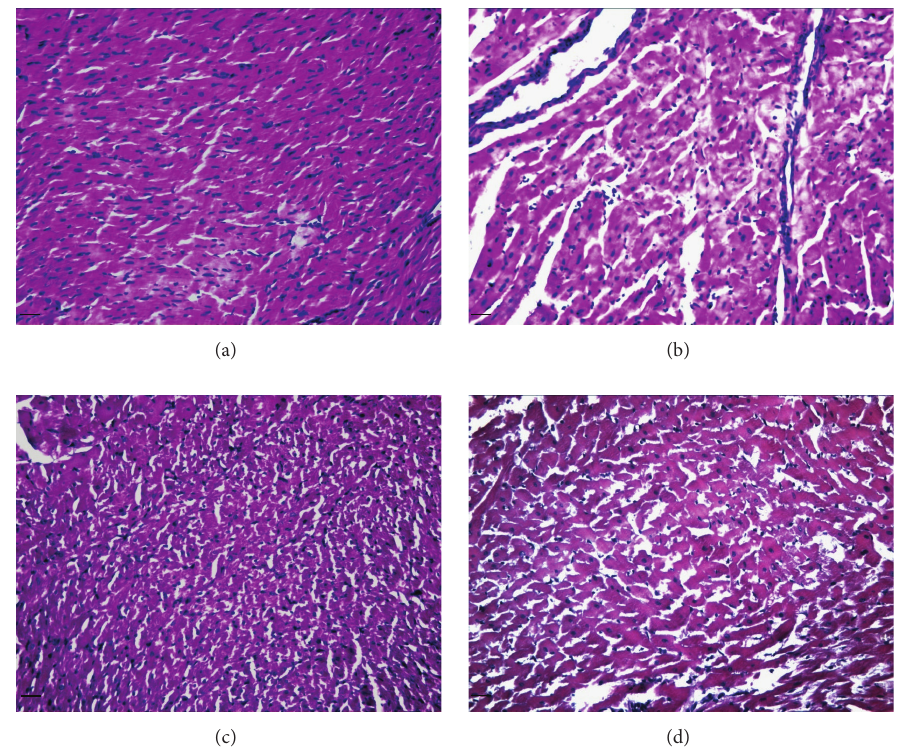
Figure 1: Representative pictures from hematoxylin and eosin staining of cardiac tissue. Rat hearts were perfused with Krebs solution containing (a) D-glucose 11.1mM (control); (b) glucose 33.3 mM (high glu); (c) high glu + BF-5m (0.1 𝜇 M); (d) high glu + BF-5m (0.1 𝜇 M) + EX527 (10mg/kg/day i.p.). 200x magnification; scale bar = 100 𝜇 m.